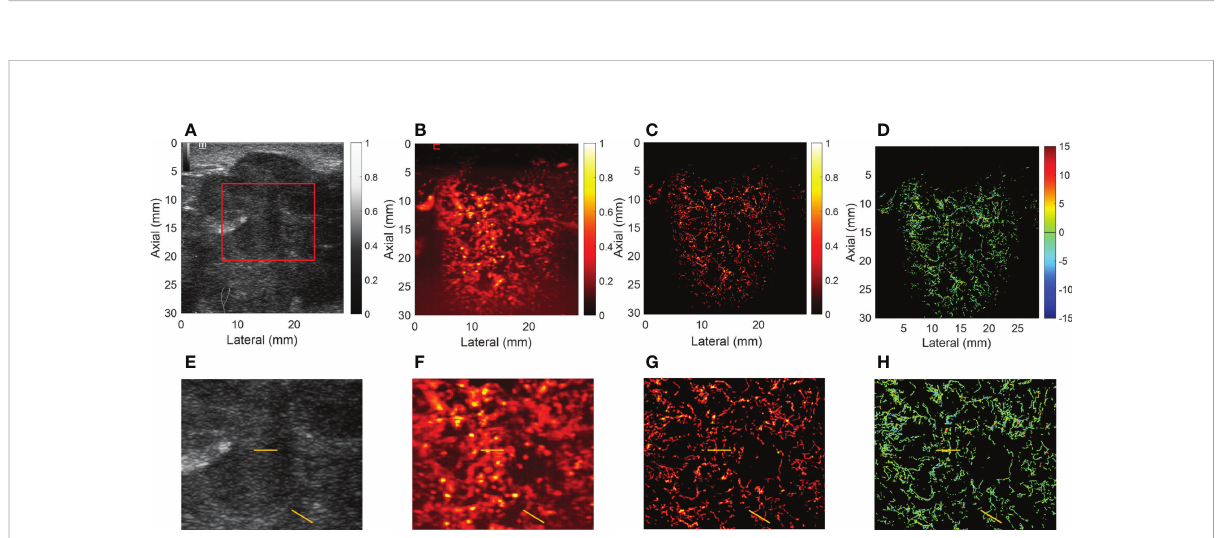
FIGURE 4 Ultrasound images of a representative malignant breast mass. (A) B-mode image. (B) Contrast-enhanced ultrasound image. (C) Super-resolution image. (D) Super-resolved velocity image. (E – H) shows the zoomed-in regions of (A – D) as the red box indicated in (A) . Yellow lines in (E – H) highlight the resolution improvement among the